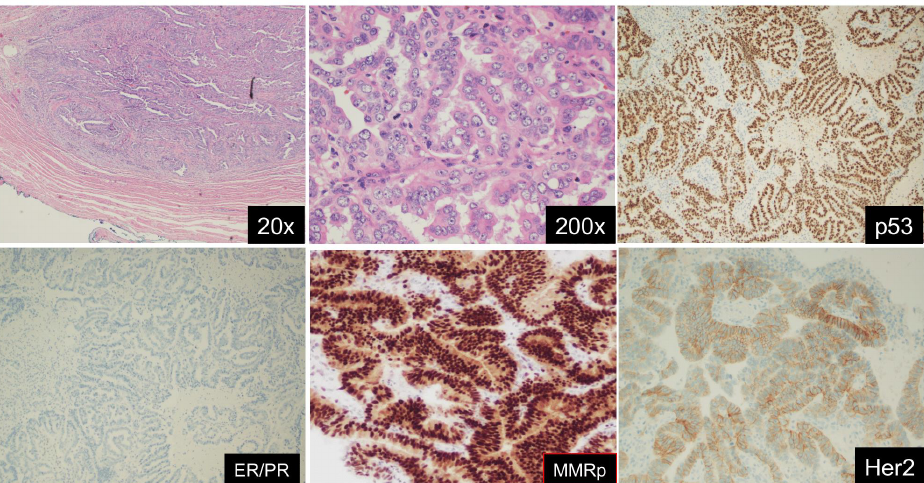
Figure 1. Endometrial serous carcinoma (ESC) with its classic immuno- and molecular profile. ESC shows deep myometrial invasion ( upper left ) and striking nuclear atypia in a high-power view ( upper mid ). Immunohistologically, the tumor shows mutant p53 ( upper right ), loss of ER/PR expression ( lower left ), proficient MMR panel ( lower mid ), and 3+ Her2/neu overexpression. By sequencing analysis, the tumor shows no POLE ultramutation (not shown). Molecular classification: TCGA group 4, p53 aberrant type.